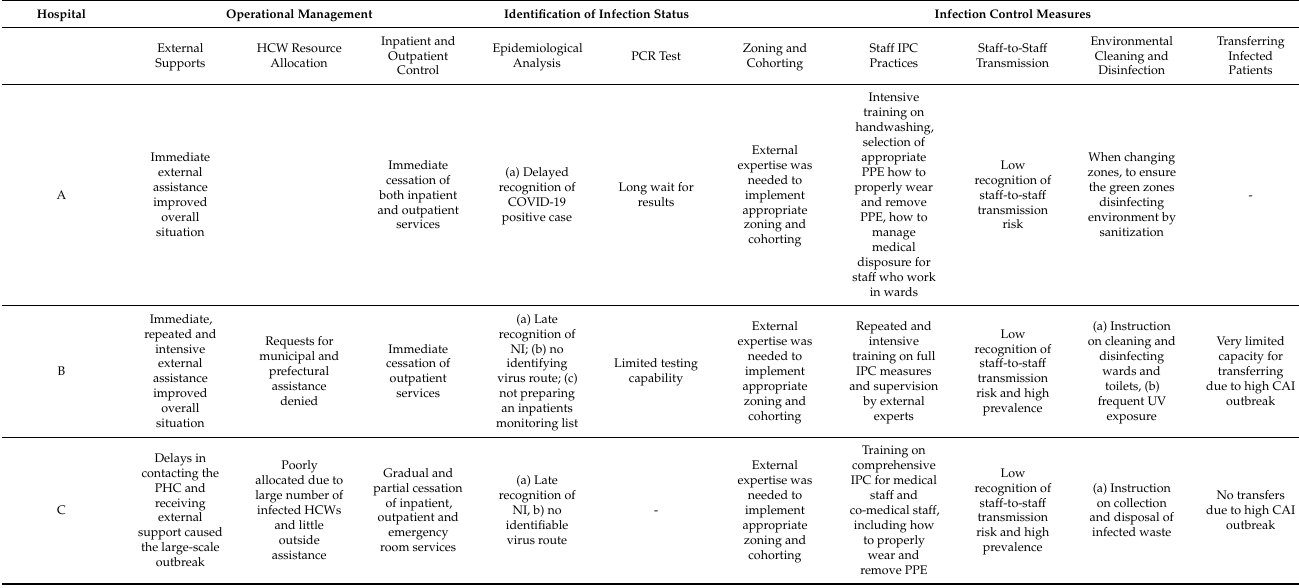
Table 6. Summary of remarkable risk factors in the spread of NI and factors in its prevention in the three